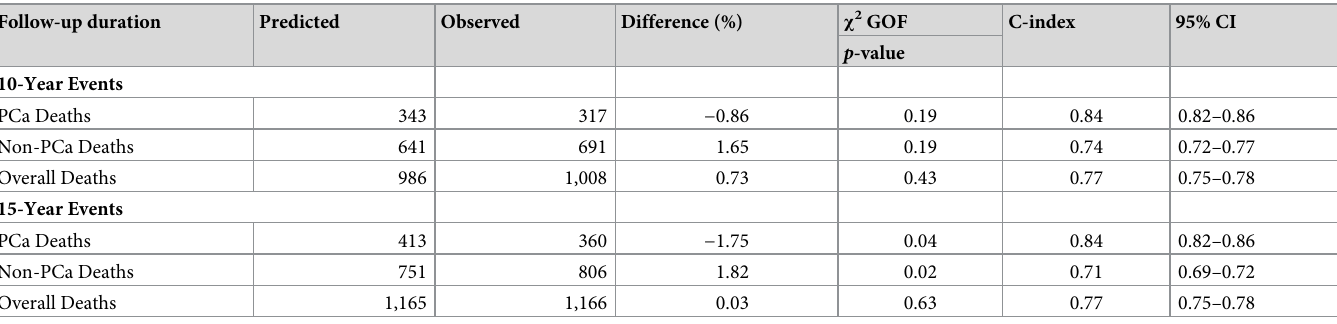
Table 3. Observed and predicted deaths over 10 and 15 years in the UK validation cohort ( n = 3,026). GOF and C-index are shown for each cause of death. Follow-up duration Predicted